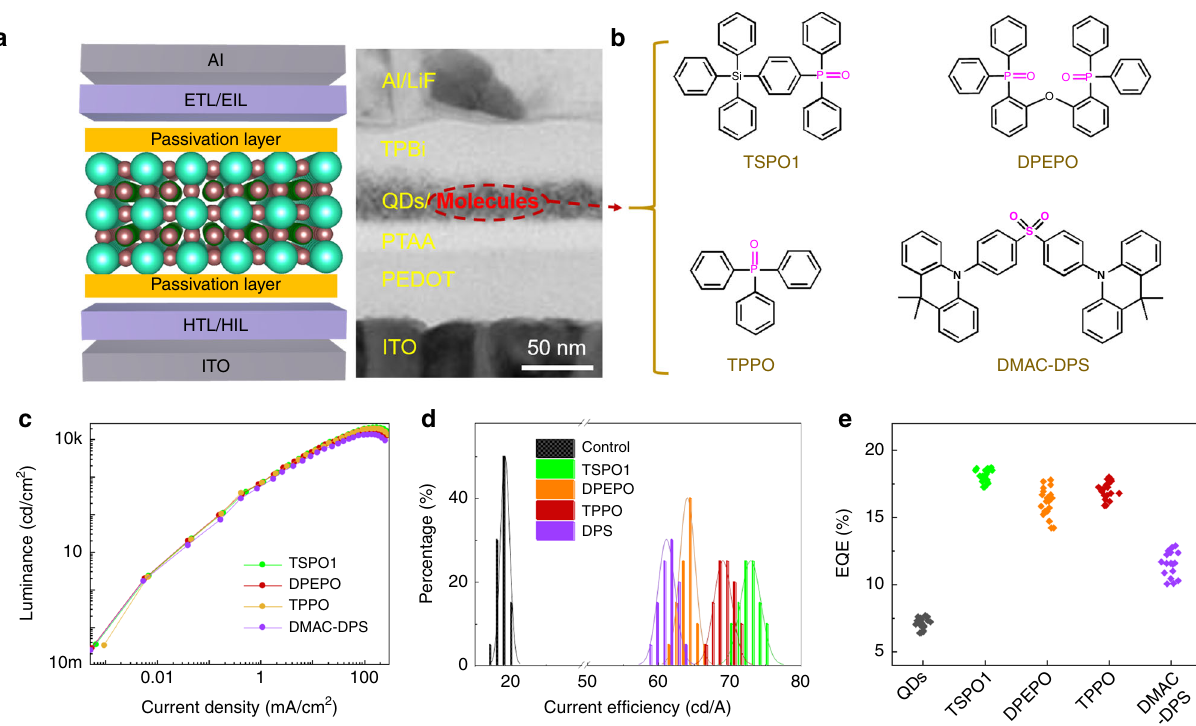
Fig. 5 EL performance of passivated QLED with various molecules. a The schematic diagram and sectional TEM image of device structure with bilateral passivation, the scale bar is 50 nm. b The molecular structure of the used passivation molecules, TSPO1, DPEPO, TPPO and DMAC-DPS. c The luminance vs. current density curves ( d ) current ef fi ciency distribution histogram and ( e ) EQE statistics of devices passivated by TSPO1, DPEPO, TPPO, and DMAC- DPS. Source data are provided as a Source Data fi le.